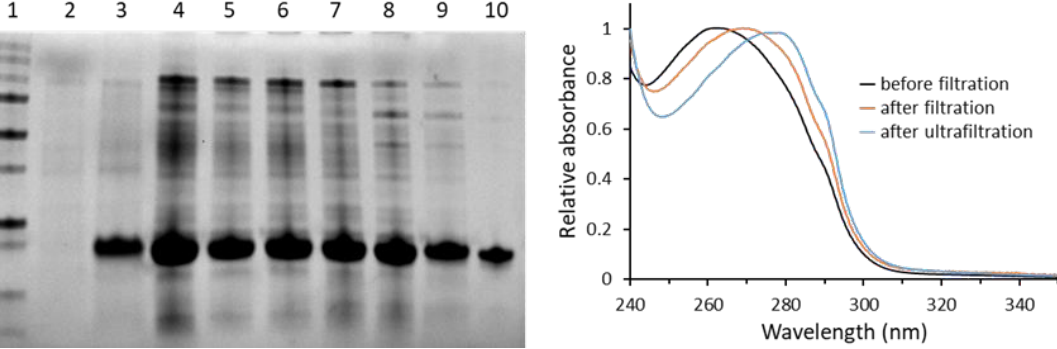
Figure 2. Protein expression and purification analyzed by SDS-PAGE and UV absorption. Lanes: 1. marker; 2. pre-induction; 3. post-induction; 4. sonication supernatant; 5. 20% ammonium sulfate supernatant; 6. 70% ammonium sulfate pellet; 7. soluble fraction after heat treatment at 62 °C; 8. soluble fraction after heat treatment at 72 °C; 9. sample filtered through diatomaceous earth; 10. sample filtered through Vivaflow200 module. DNA removal of samples 8, 9 and 10 was followed by UV absorption.